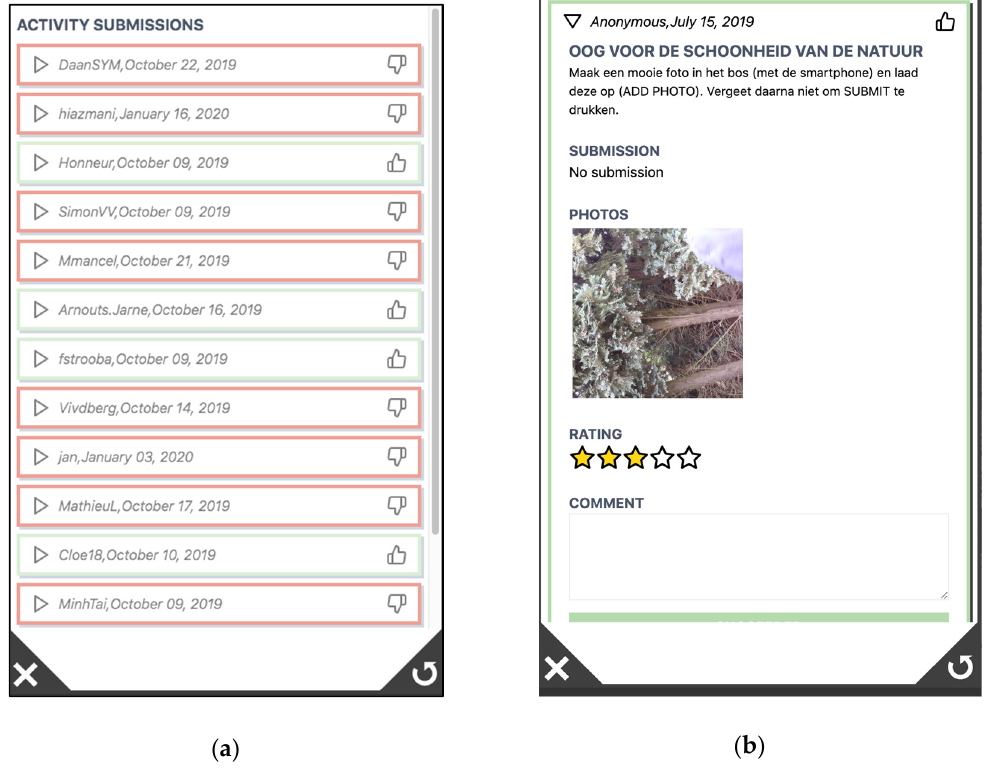
Figure 9. (a) Interface in the supervisor module for inspecting who could collect the card and who could not; (b) Interface for rating an open question.